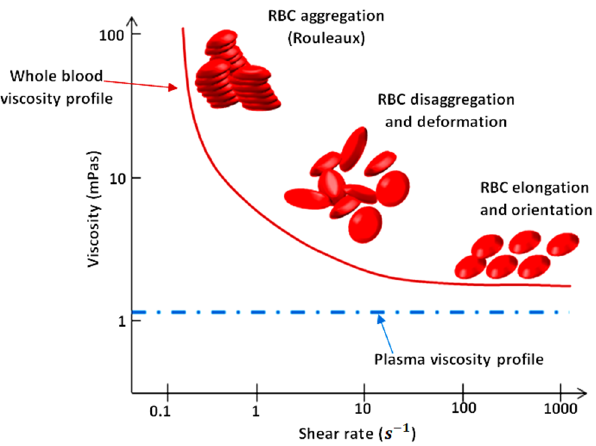
Figure 1. Viscosity profiles of whole blood and plasma. Adapted from Rosencranz [7]. The gold standard for viscosity measurements comprises a wide range of types of rheometers (instruments that measure the stress and deformation history of a material).